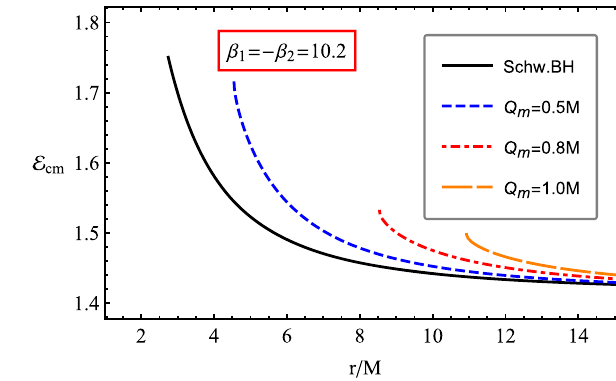
Fig. 10 The dependence of the center-of-mass energy of collision of two magnetized particles with the same value of initial energy = E = 1 and the parameter β = 10 . 2 from the radial coordinate, E 1 2 around the magnetically charged RN black hole for different values of the magnetic charge parameter of the black hole. The top panel cor-